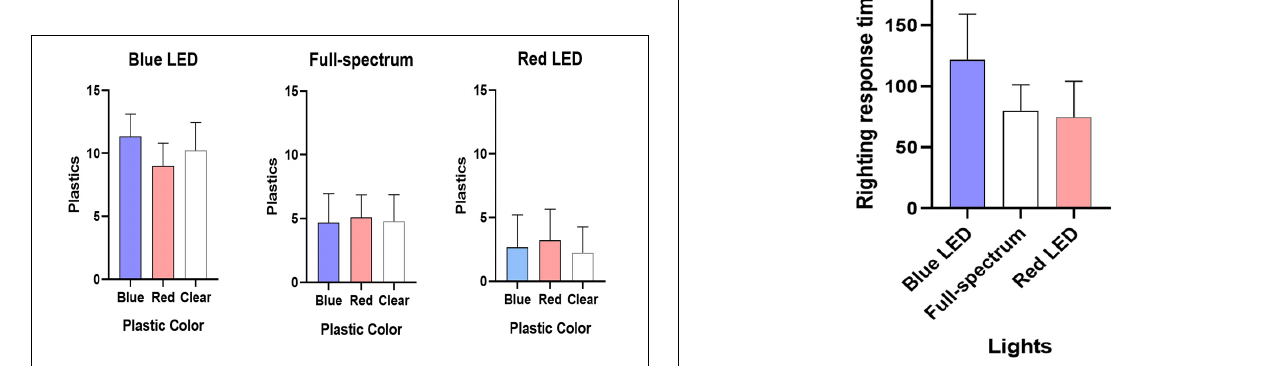
FIGURE 6 | Righting response time of T. gratilla under different wavelength LED illumination. Each value represents mean ±